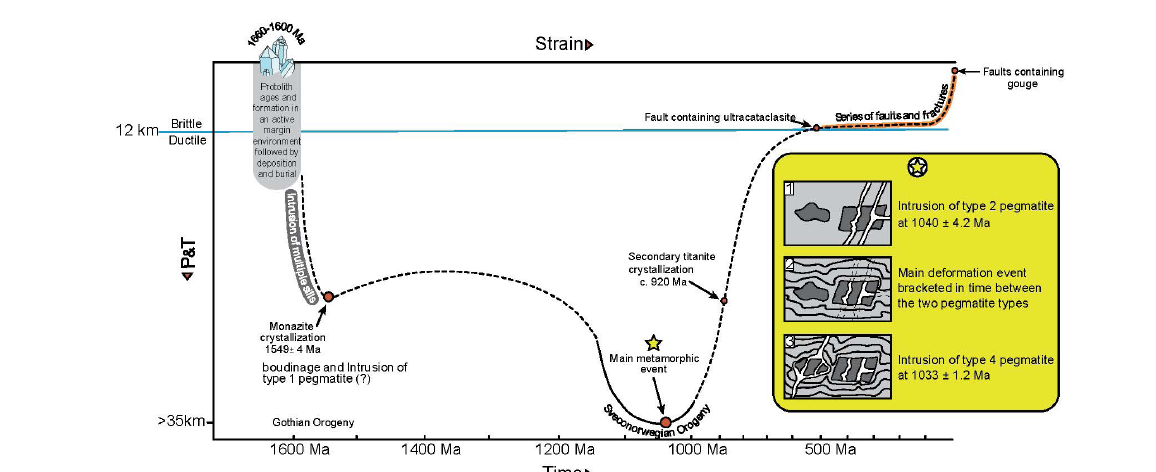
Figure 9. Tectonic and metamorphic evolution of Halden gneiss and shear zone inferred from this study.